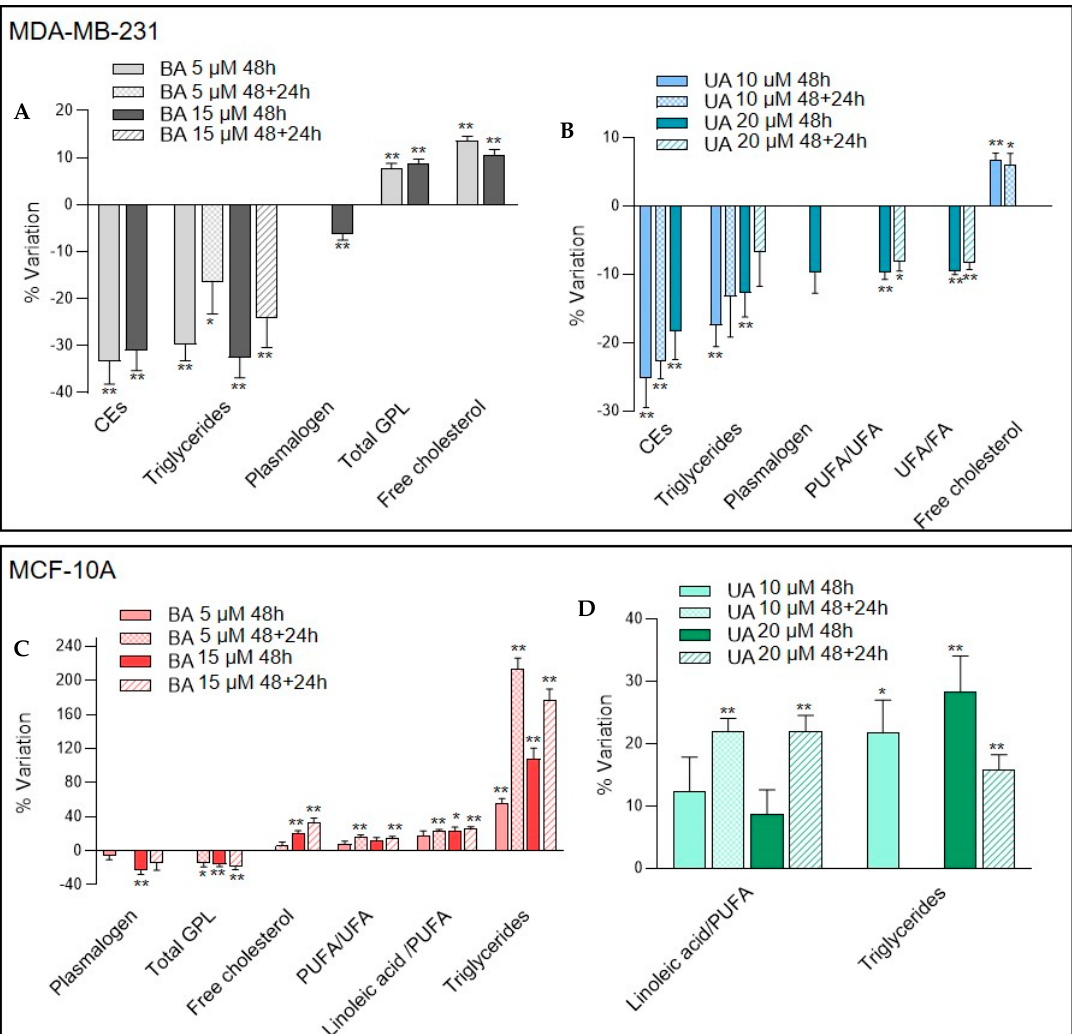
Figure 5. Lipid-related variations in organic extracts from MDA-MB-231 breast cancer cells ( A , B ) and MCF-10A cells ( C , D ), treated with betulinic acid (BA) or ursolic acid (UA), relatively to untreated controls. Four independent replicates considered. ** p-value < 0.01; * p-value < 0.05. CEs, cholesteryl esters; PUFA, polyunsaturated fatty acyl chains, UFA, unsaturated fatty acyl chains; GPL, Glycerophospholipids; FA, total fatty acids. Different scale used in each graph according to variation range.